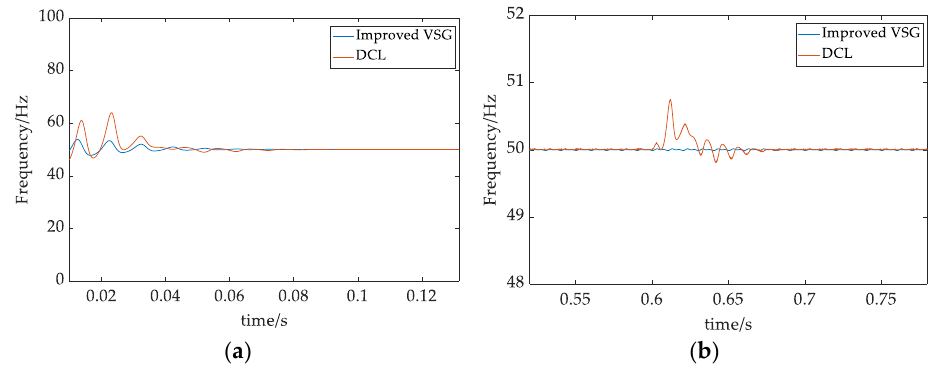
Figure 20. Output frequencies of MMC-RPC under two control methods of 5 MW load change. Partial diagram of output frequencies by setting: ( a ) MMC-RPC is put into operation, ( b ) sudden load change.